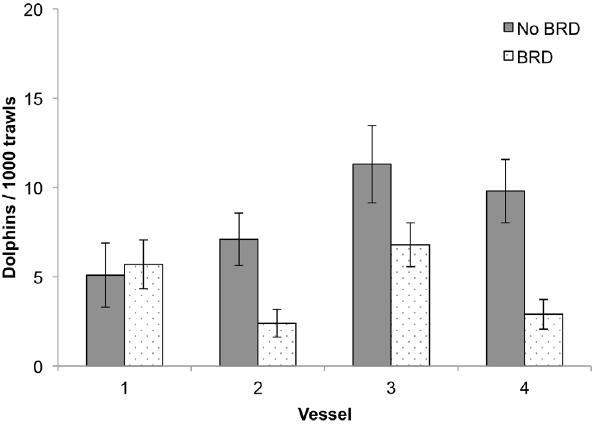
Figure 5. Dolphin bycatch rates net type x vessel interaction. Mean ( 6 1 SE) dolphin bycatch rates illustrating the net type (No BRD vs BRD) x vessel (1-4) interaction based on skippers’ logbook data.